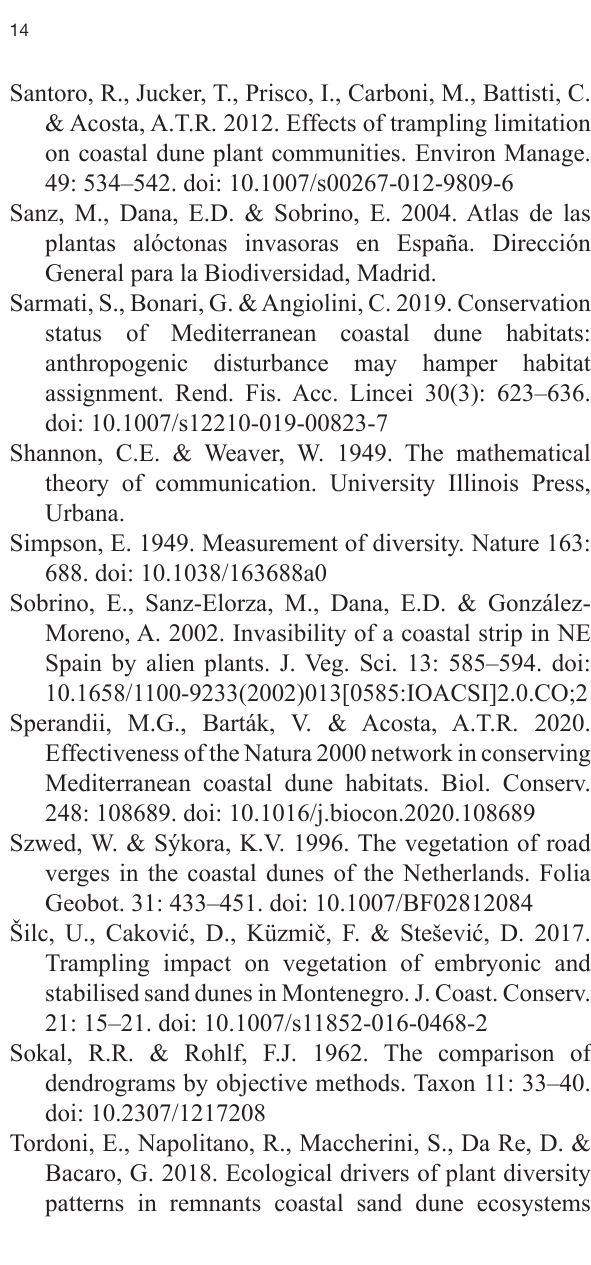
Table S1. Plant occurrence in the studied